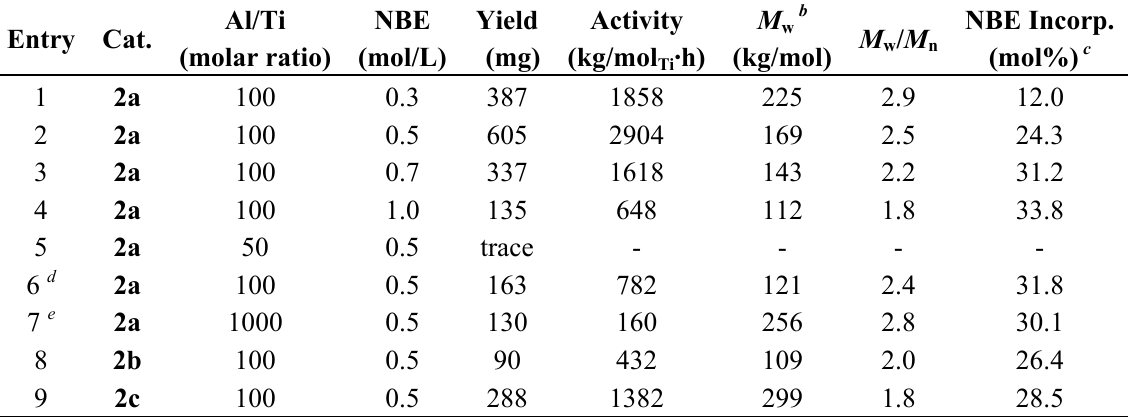
CB(C F ) / i Bu Al a . 3 6 5 4 3